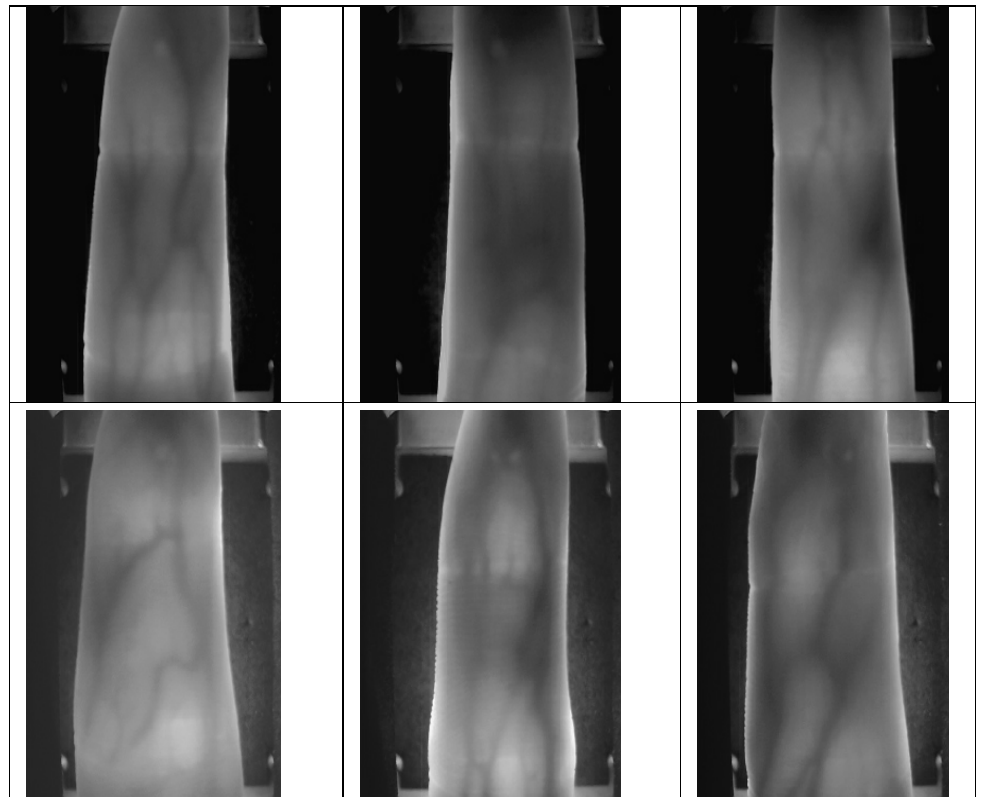
Figure 6. Sample finger vein